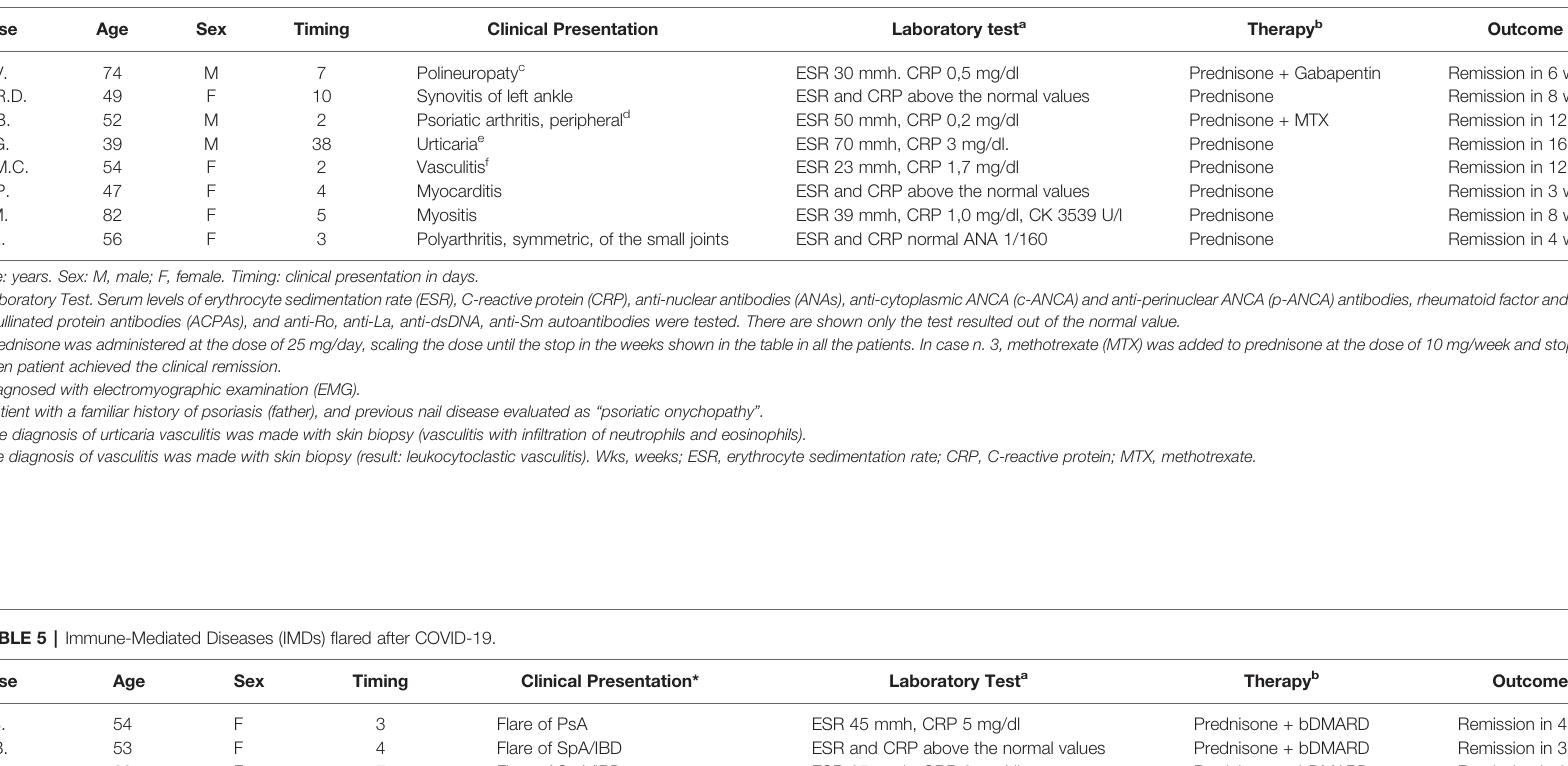
ESR and CRP above the normal values Prednisone + bDMARD Remission in 3 wks